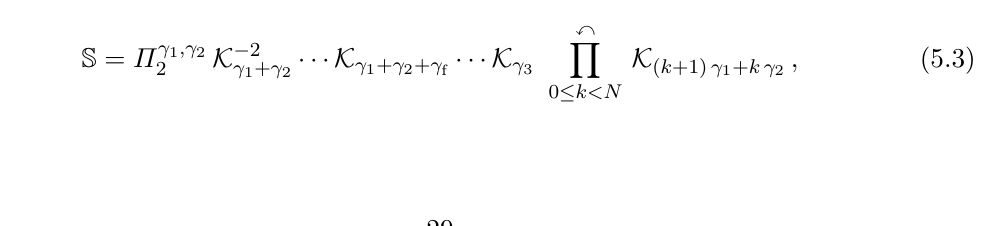
Figure 15 . Charge rays Z ( γ ; u ) of the γ γ γ γ γ γ 1 + 2 , 3 and 1 + 2 + f become separated, and the perturbations of to new